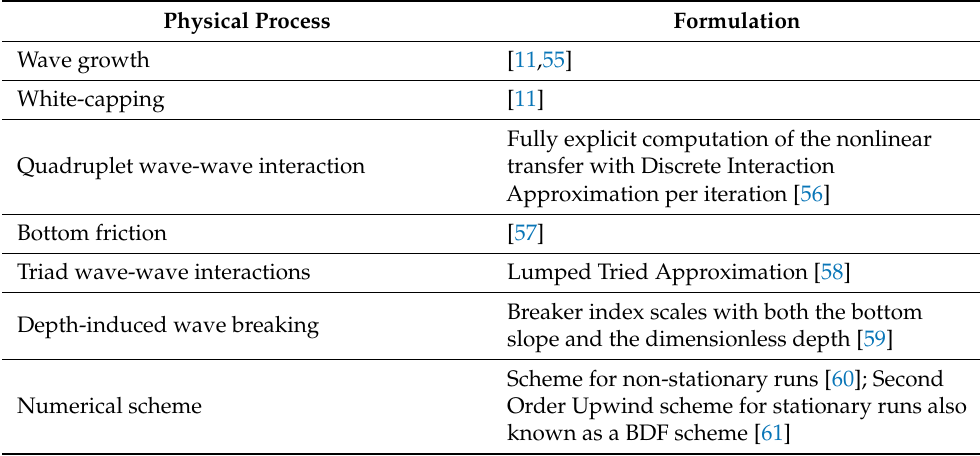
Table 1. SWAN wave simulations